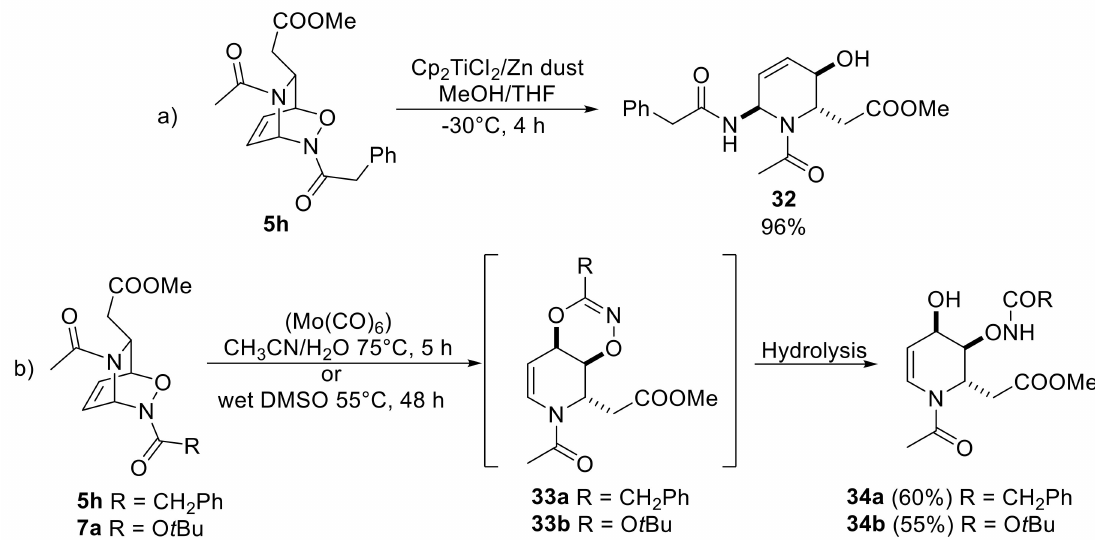
cleavage of the N − O bond. Conditions b : [3,3]-rearrangement.